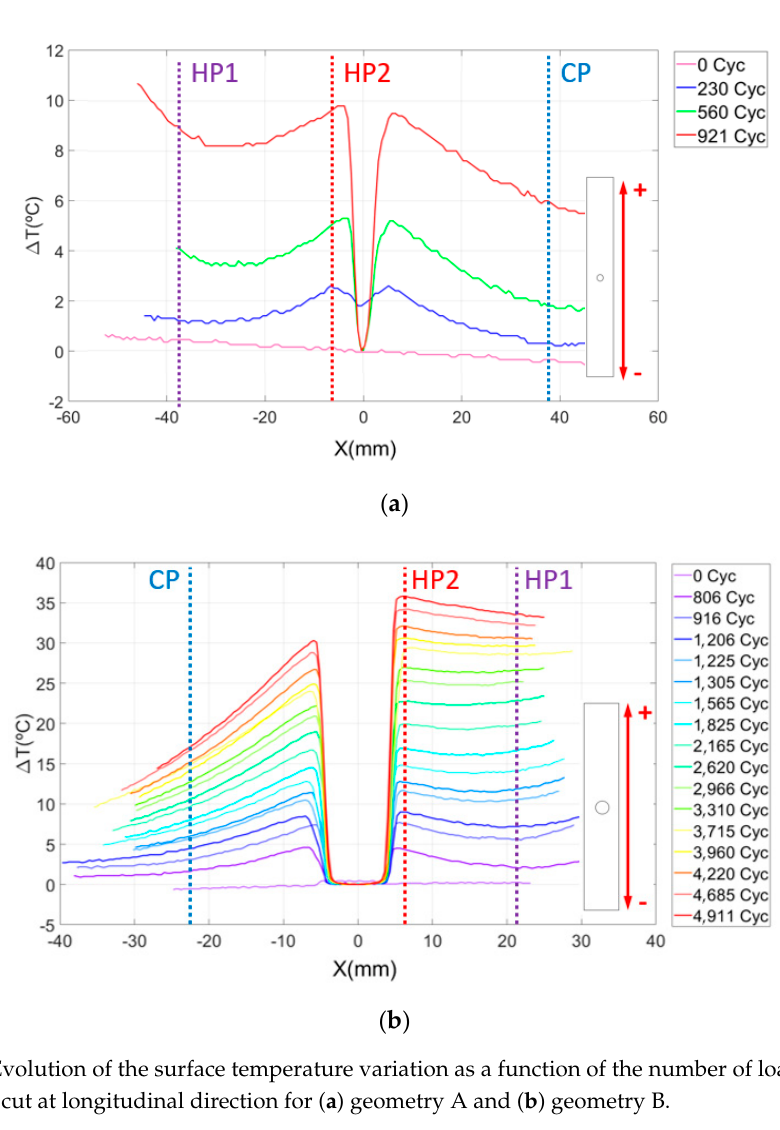
Figure 8. Evolution of the surface temperature variation as a function of the number of load cycles in specimens cut at longitudinal direction for ( a ) geometry A and ( b ) geometry B.